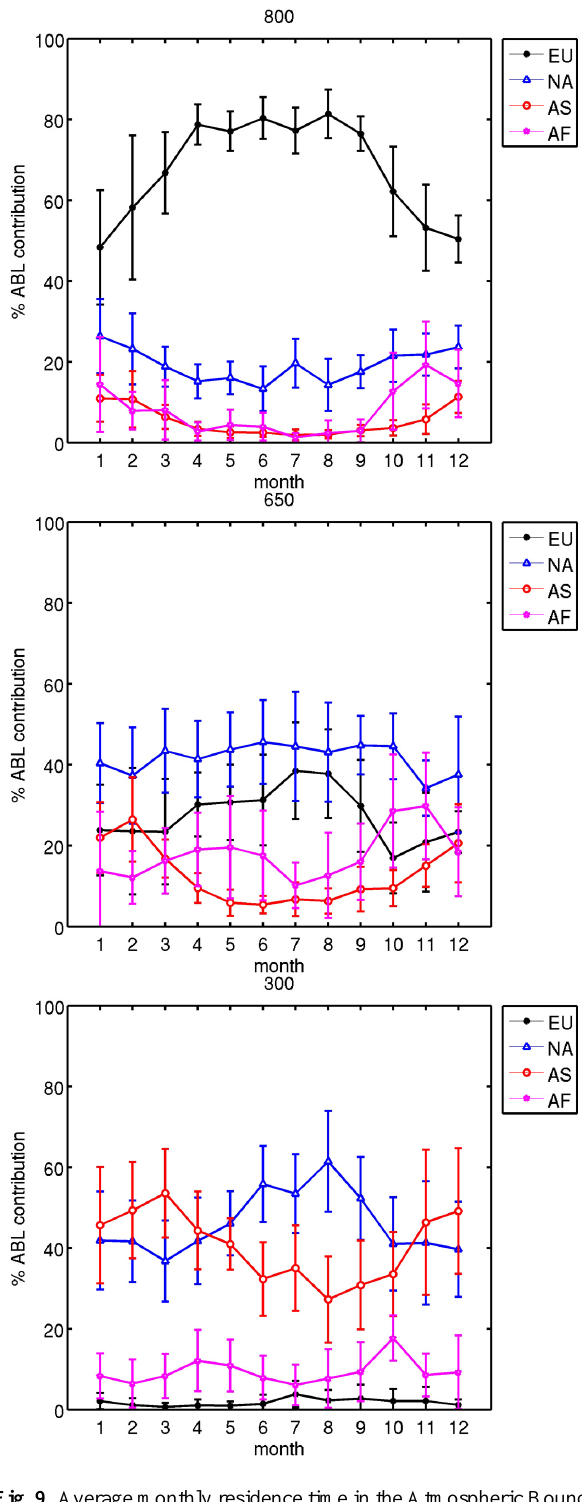
Fig. 9. Average monthly residence time in the Atmospheric Bound- ary Layer (ABL) per region (EU: Europe, NA: North America, AS: Asia, AF: Africa) relative to the total ABL residence time arriv- ing at Jungfraujoch at 800 (top), 650 (middle) and 300hPa (bottom plot). The error bars correspond to the 1 σ standard deviation, de- rived from analysing the yearly contributions